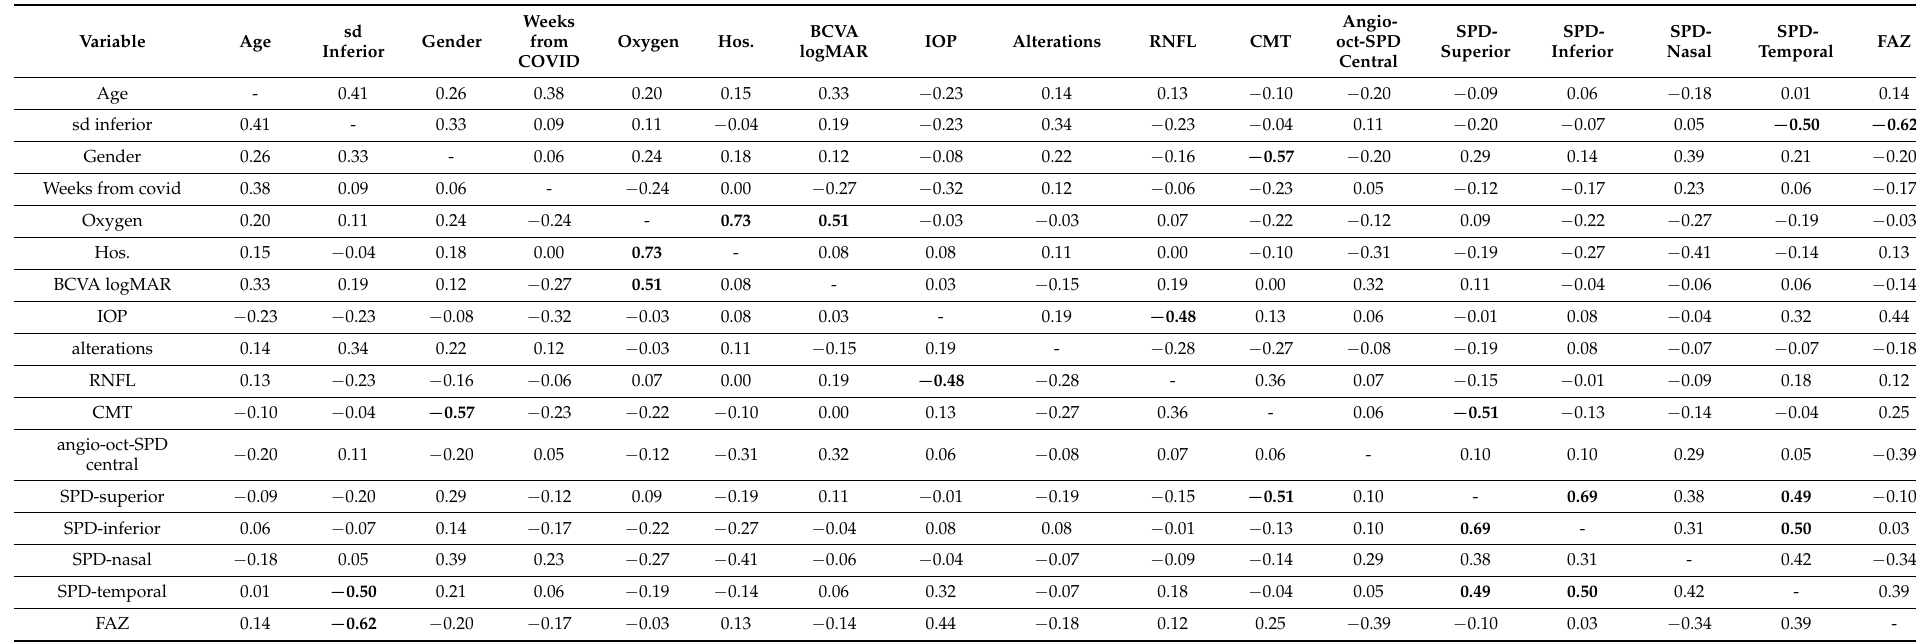
Table 3. Pearson correlation coefficient matrix for IOP; fundus alterations; RNFL; CMT; OCT-a—central, superior, nasal, inferior, and temporal; FAZ; gender; weeks post COVID-19; oxygen supplementation; and hospitalization. Statistically significant correlations are in